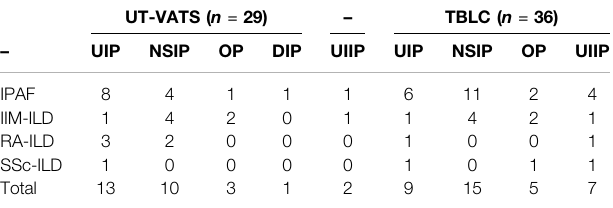
TABLE 4 | The strati fi cation of pathological information with different biopsy